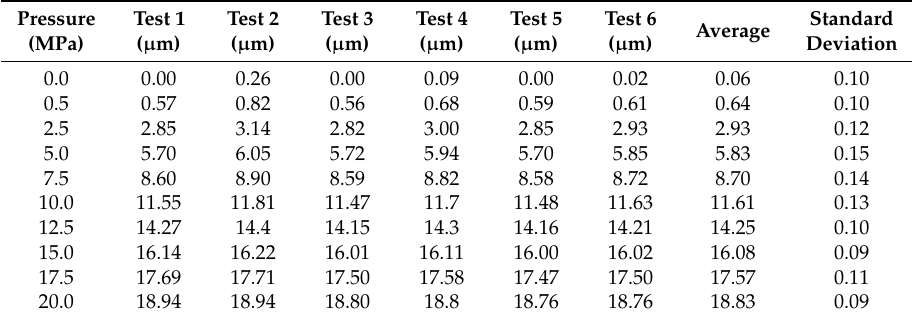
Table 2. 6 times measured results of diaphragm deflection according to varied pressure